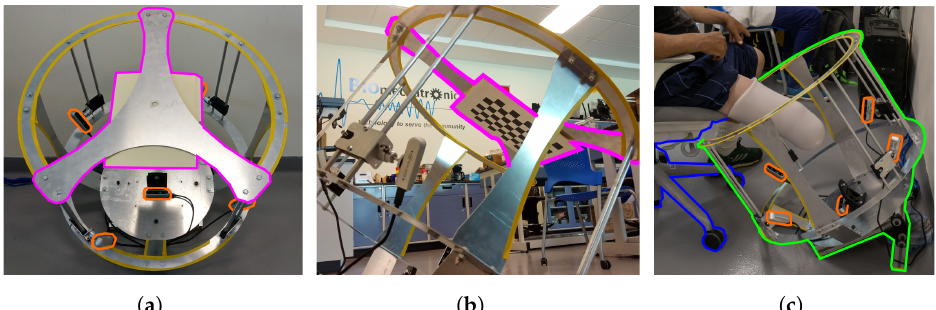
Figure 8. The configuration used for participants shows: ( a ) the workspace of the system being calibrated; ( b ) the removable support for target calibration in magenta; and ( c ) the interaction with the participant. Demonstrating the positions of camera mounts and their ability to change orientation to focus on the objective.